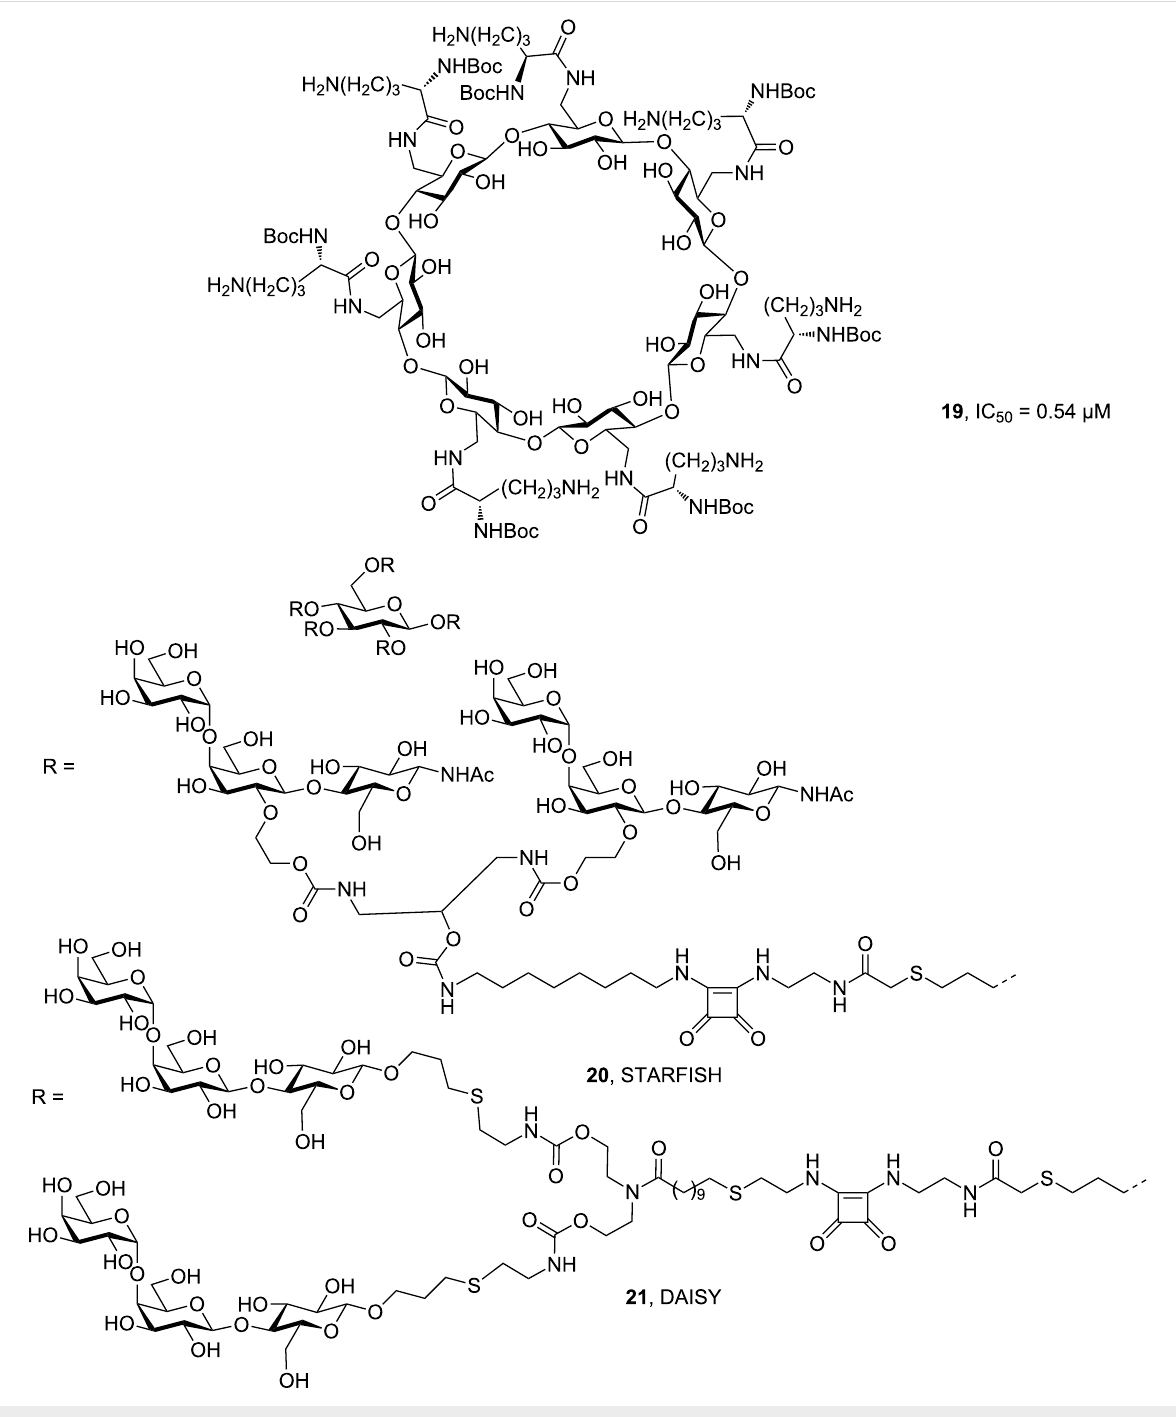
Figure 4: β -Cyclodextrin-based antitoxin 19 against S. aureus α -hemolysin and the decavalent Shiga toxin inhibitors STARFISH ( 20 ) and DAISY ( 21 ).